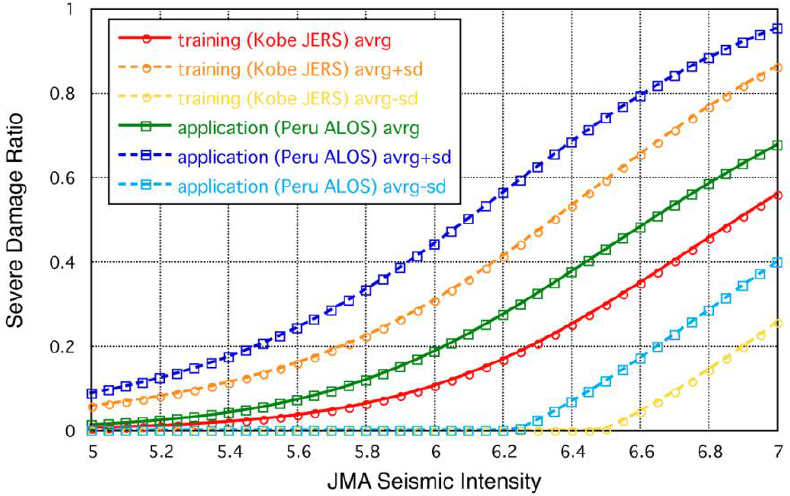
Figure 8. Relationship between seismic intensity and severe damage ratio (average value [red], with plus and minus standard deviations [dark and light yellow]) [12]. The modified curves (average [green], with plus and minus standard deviations [dark and light blue]) are also shown for the Peru earthquake case.